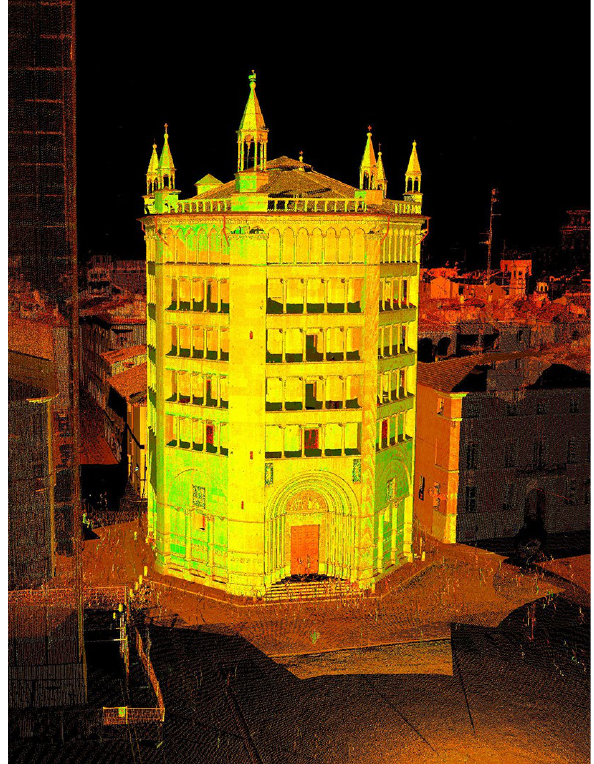
Figure 3. Point cloud from laser-scanning